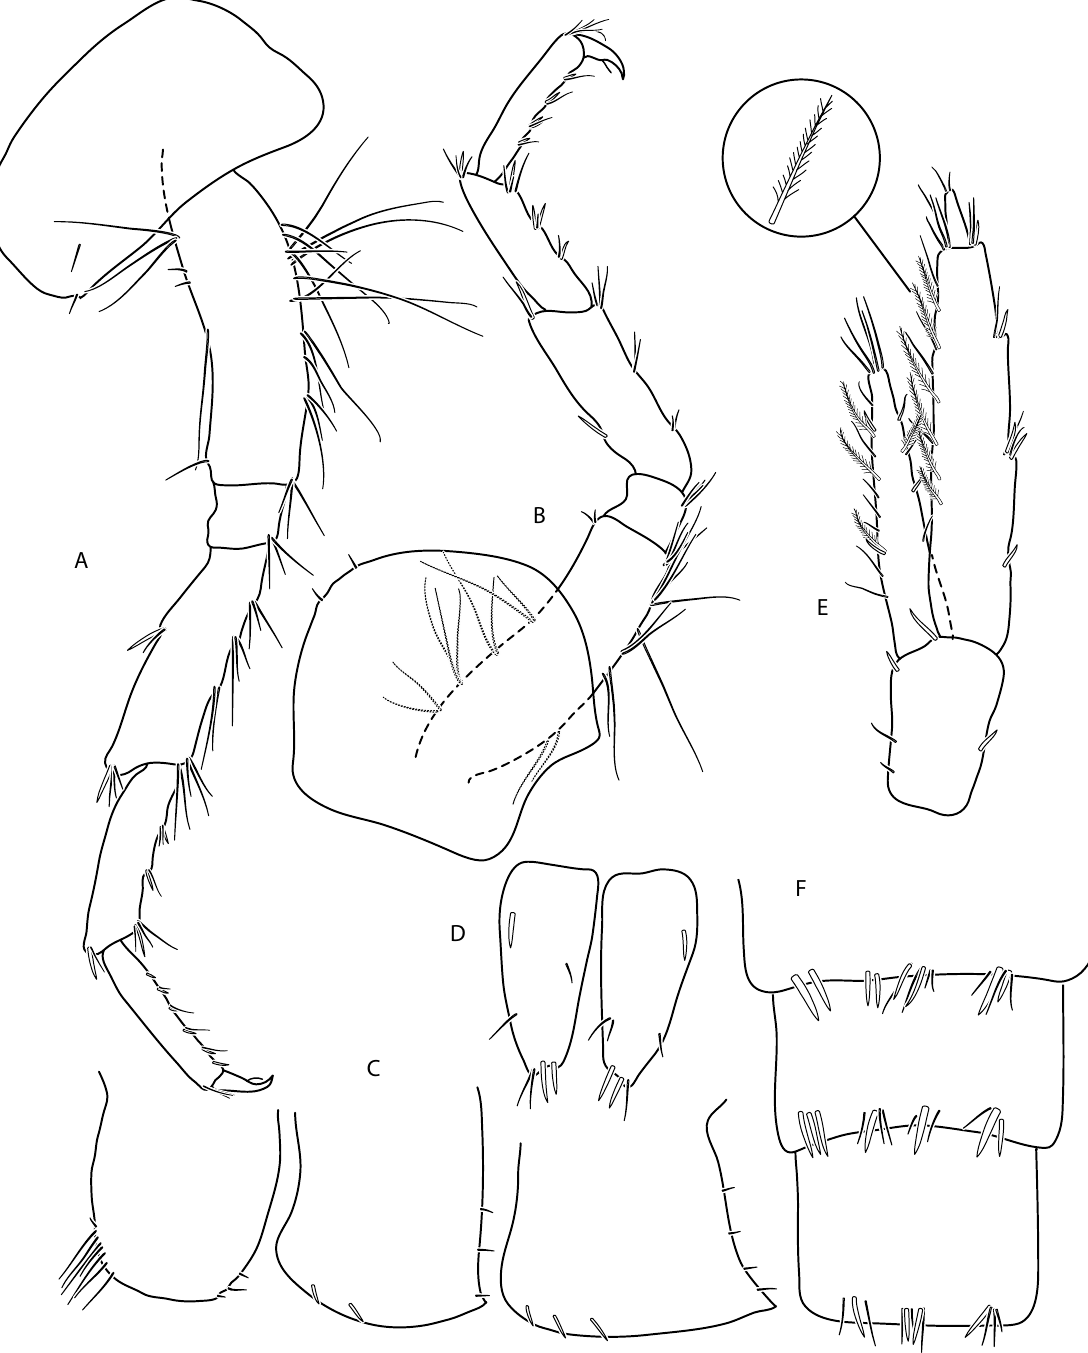
Figure 11. Gammarus tatrensis , male—14 mm. ( a ) pereopod 3, ( b ) pereopod 4, ( c ) epimera 1- 3, ( d ) telson, ( e ) uropod 3, ( f ) Gammarus tatrensis , male—12 mm